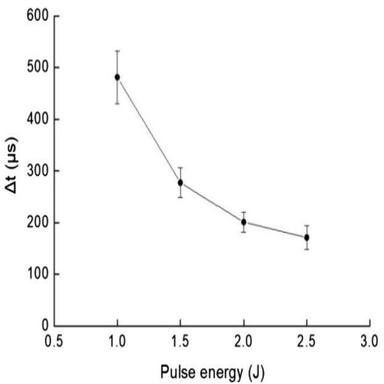
Influence of the laser pulse energy on the moment of the initial signal detected near and below the hole exit during the process of through-hole drilling using the third laser pulse.